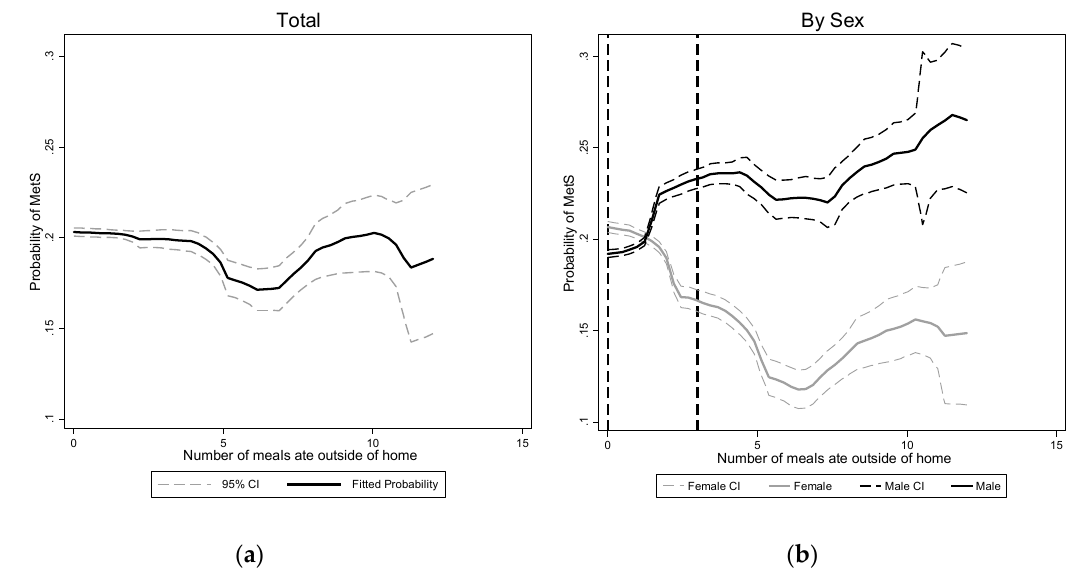
Figure 1. Associations between predicted probability of having metabolic syndrome diagnosis and EAFH. ( a ) Association for the whole sample; ( b ). Associations for female and male respectively. Note: The solid black line indicates the fitted probability of having metabolic syndrome, and the two dash lines indicate the 95% CI of the fitted probability. The two dashed vertical lines refer to the two cut-off points of frequency of EAFH (0 and 3). Fitted probabilities were estimated using logistic regression, after adjusting for age, educational level (primary, middle, and high), logarithm of income, smoking (yes/no), drinking (currently drinking or not), physical activity (light, moderate, and heavy), localization (urban or rural; north or south), total energy intake and fat share. For total population regression, sex and its interaction term with frequency of EAFH was also added as covariates.